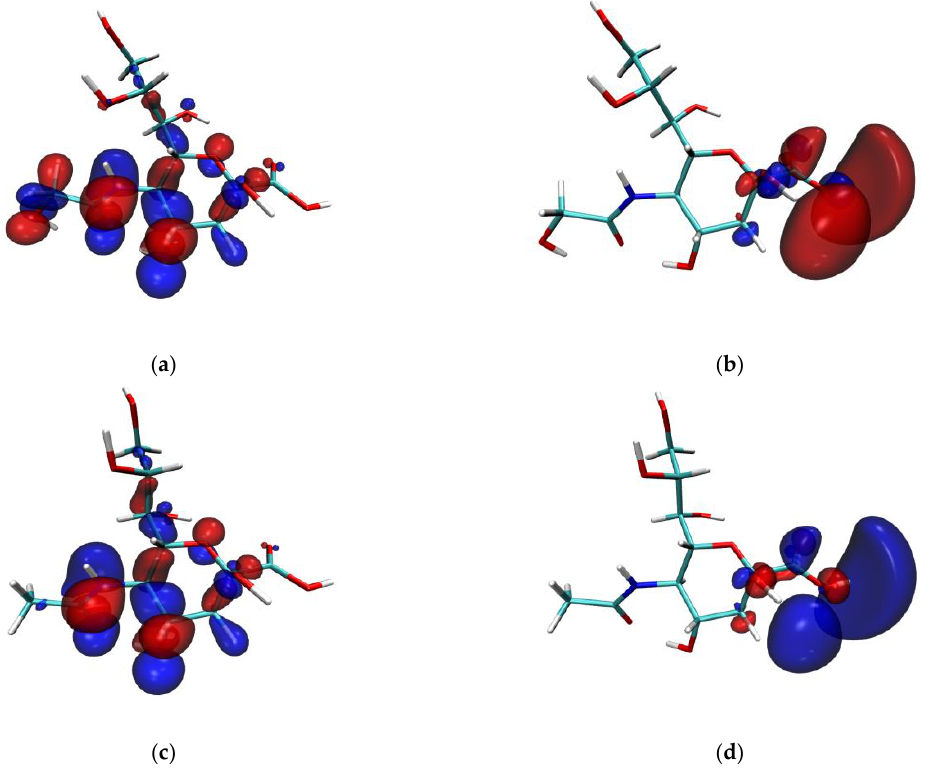
Figure 2. The highest occupied molecular orbital (HOMO) and the lowest unoccupied molecular orbital of Neu5Gc and Neu5Ac. Note: ( a ) The HOMO of Neu5Gc; ( b ) The LUMO of Neu5Gc; ( c ) The HOMO of Neu5Ac; ( d ) The LUMO of Neu5Ac.